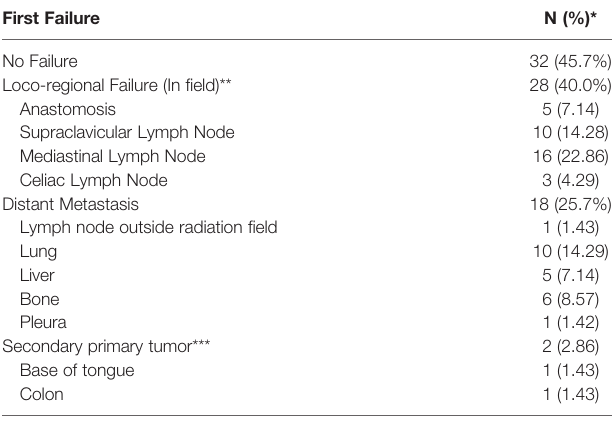
TABLE 3 | Patterns of First Treatment Failure D . First Failure